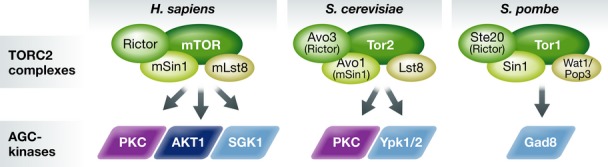
TORC2 complex signaling to AGC kinasesShown is a summary of TORC2 in human, S. cerevisiae and S. pombe. The human proteins Rictor and Sin1 are TORC2-specific subunits conserved in both yeast species, being known as Avo3 (Rictor) and Avo1 (Sin1) in S. cerevisiae (Loewith et al, 2002) or Ste20 (Rictor) or Sin1 in S. pombe (Hayashi et al, 2007; Matsuo et al, 2007). The target kinases of TORC2 are AKT1 (Sarbassov et al, 2005), SGK1 (Garcia-Martinez & Alessi, 2008), PKC-α (Facchinetti et al, 2008; Ikenoue et al, 2008), and PKC-ζ (Li & Gao, 2014) in higher eukaryotes, while they are Ypk1 and Ypk2 (Kamada et al, 2005), and the PKC ortholog Pkc1 (Facchinetti et al, 2008) in budding yeast. Fission yeast has only one identified AGC-kinase, Gad8 (Matsuo et al, 2003).